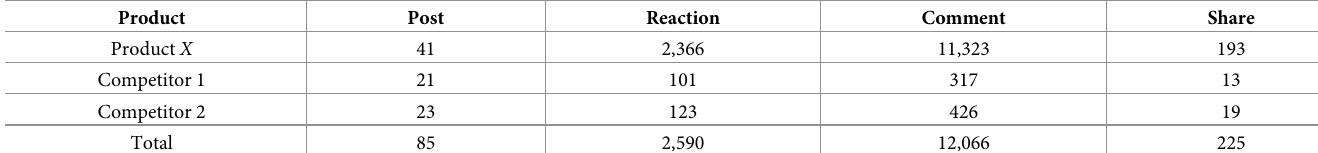
Table 3. Compare the interactions related to brand X and competitor products from 13–23 Feb. 2020.